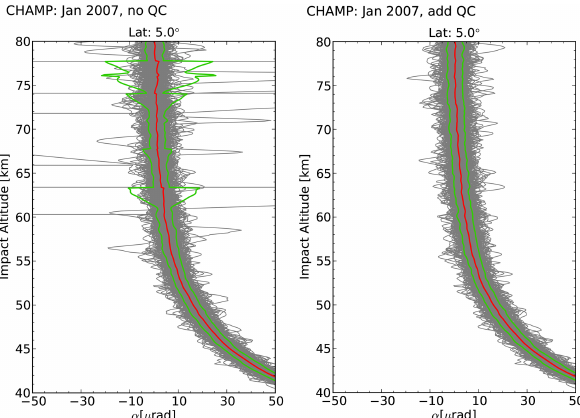
Figure 2. The left-hand plot shows all observational bending-angle profiles for the northern fundamental bin at mean latitude 5 ◦ , while the right-hand shows the same but outliers ± 30µrad have been re- jected. The blue line represents the mean value of all profiles for each bin, the green line its standard